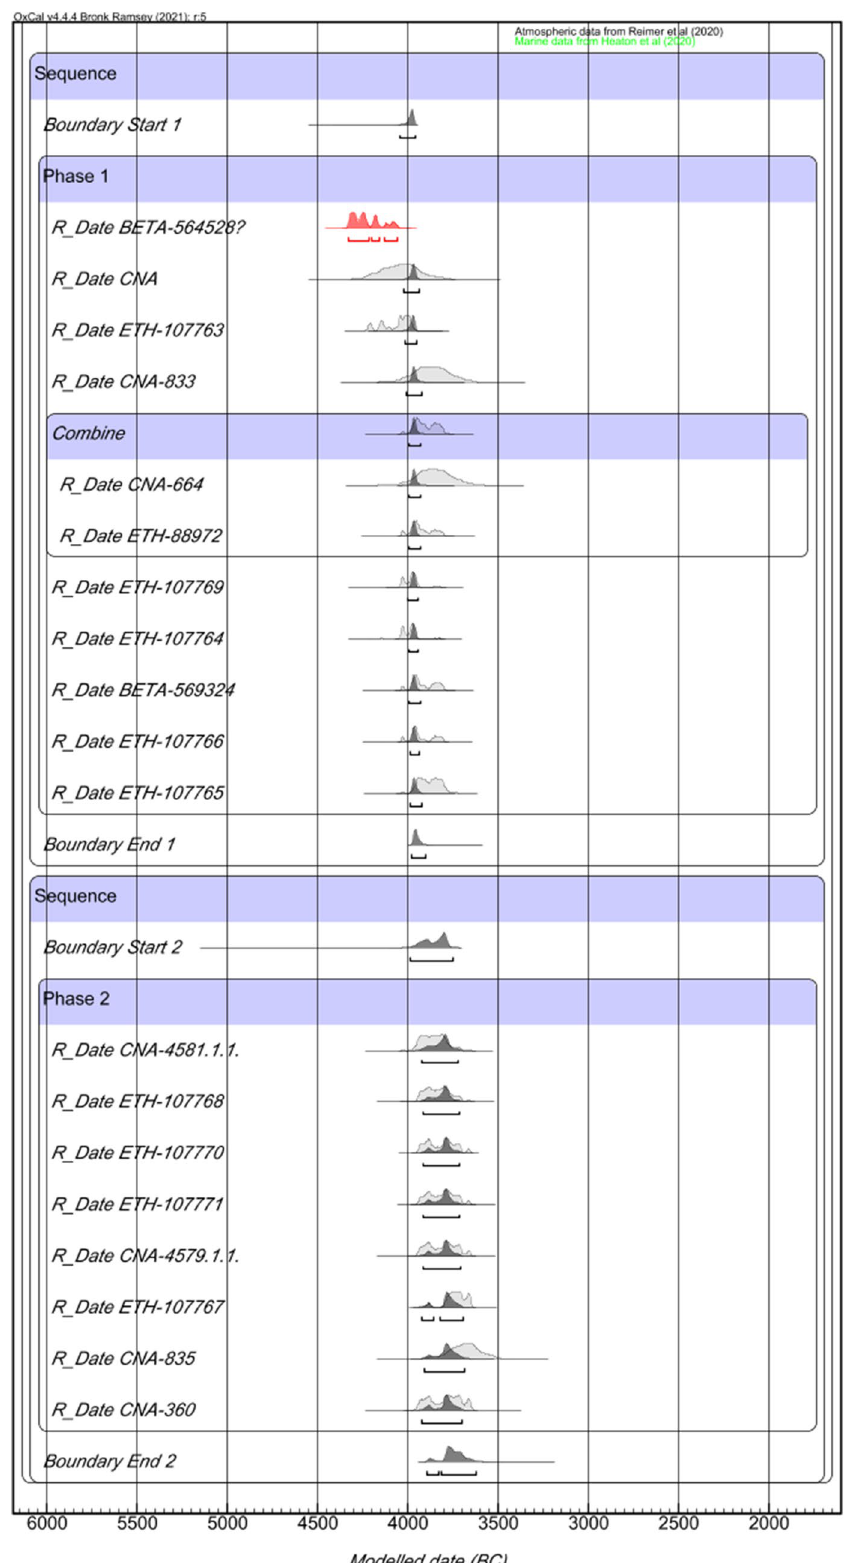
Figure 3. Overlapping Phases, Bayesian Modelling of radiocarbon dates from Campo de